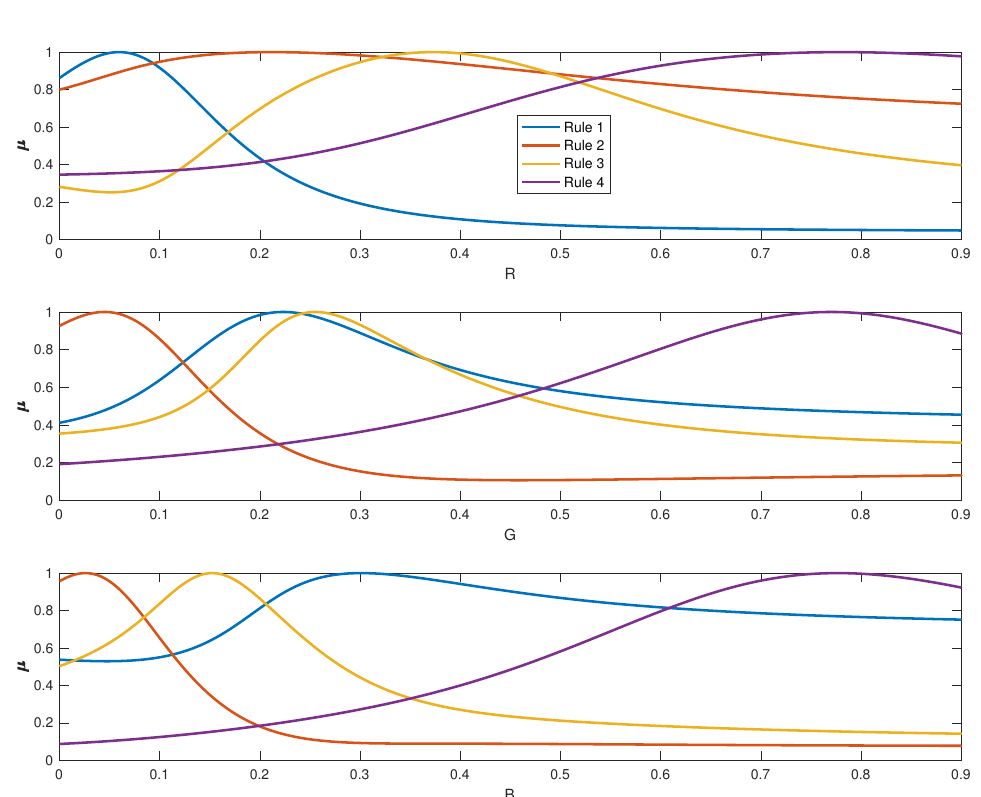
Figure 13. Membership functions for the clusters identified from the RGB training dataset. Fuzzy membership degree of each data to each fuzzy set is denoted by µ for simplicity (y